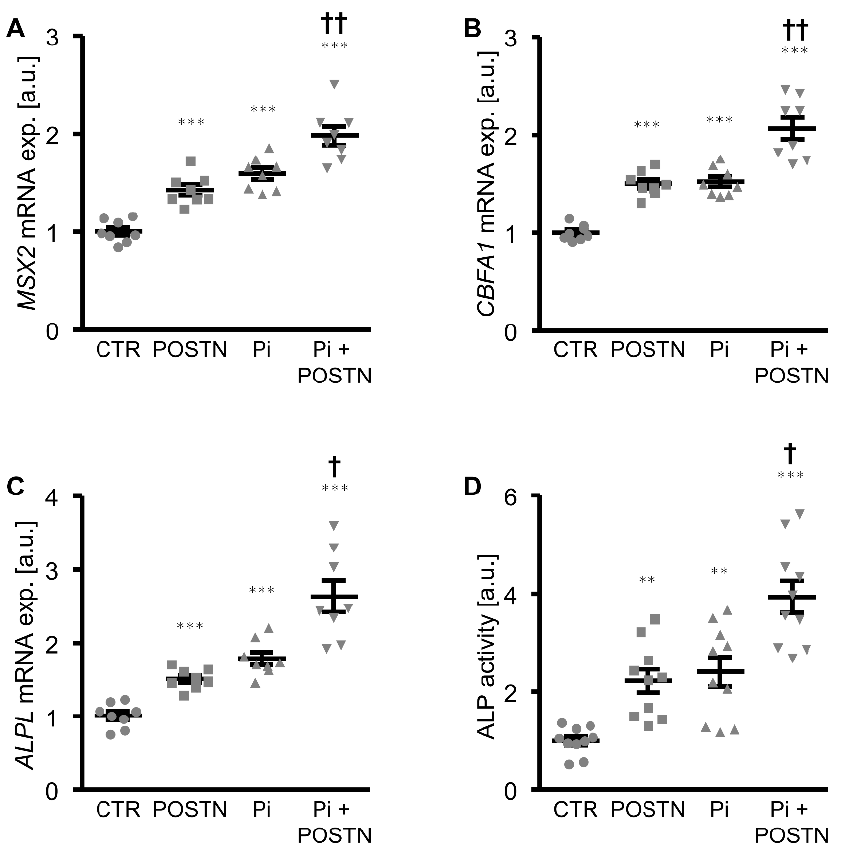
Figure 2. Periostin increases osteogenic signaling and augments osteoinduction promoted by phos- phate in HAoSMCs. ( A – C ) Relative mRNA expression of MSX2 ( A ), CBFA1 ( B ) and ALPL ( C ) in HAoSMCs treated with control (CTR) or β -glycerophosphate (Pi) without or with additional treat- ment with recombinant human periostin (POSTN). ( D ) Normalized ALP activity in HAoSMCs treated with control (CTR) or β -glycerophosphate (Pi) without or with additional treatment with recombi- nant human periostin (POSTN). ** p < 0.01; *** p < 0.001 (significant difference versus CTR group); † p < 0.05; †† p < 0.01 (significant difference versus Pi group). To elucidate the mechanisms involved in the pro-calcific effects of periostin in the HAoSMCs, the potential role of the WNT/ β -catenin pathway as a mediator was investi- gated. The addition of periostin to the cell culture medium significantly upregulated the WNT7A and WNT3A mRNA expression and β -catenin protein abundance in the HAoSMCs (Figure 3A–C). Furthermore, the mRNA expression of MMP2 and PIT1 , β -catenin target genes with key roles in VSMC calcification, was significantly higher in the periostin- exposed HAoSMCs than in the control HAoSMCs (Figure 3D,E). An additional treatment of HAoSMCs with WNT/ β -catenin pathway inhibitors (LGK974, which inhibits WNT post- translational acylation; XAV939, which stimulates β -catenin degradation; or PRI-724, which blocks the interaction of the coactivator CBP with β -catenin) all significantly suppressed periostin-induced MMP2 , PIT1 and the osteogenic marker mRNA expression (Figure 4). Taken together, the pro-calcific effects of periostin in the HAoSMCs were mediated, at least partly, by the WNT/ β -catenin signaling